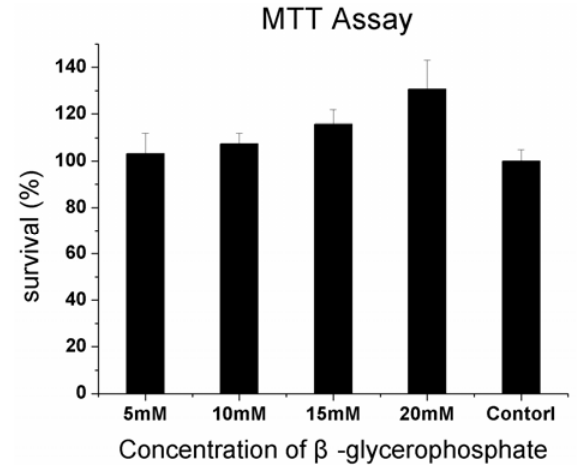
Figure 3. Cytotoxicity assay examined by MTT. Four concentrations of β -glycerophosphate did not inhibit the growth of DPSCs with the cell survival approximately 100%.